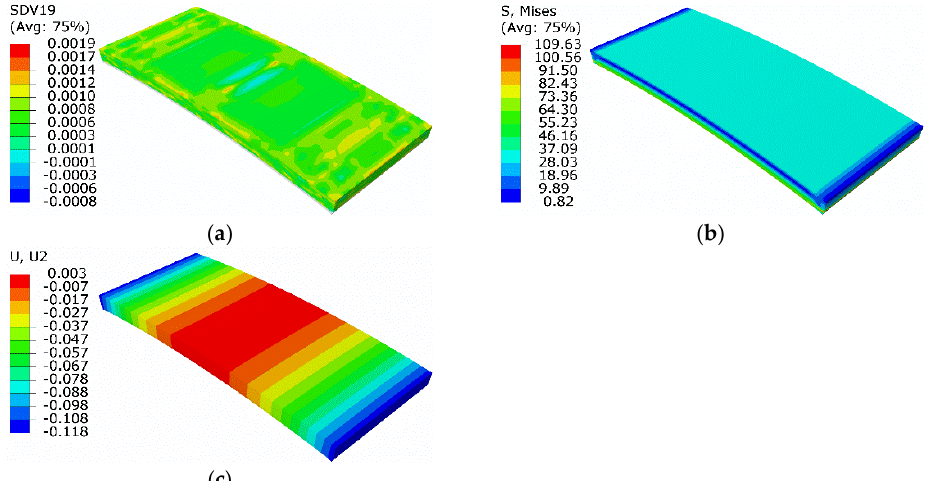
Figure 10. Results at the end of temperature rising: ( a ) volume fraction of detwinned martensite; ( b ) equivalent stress; ( c ) normal displacement.